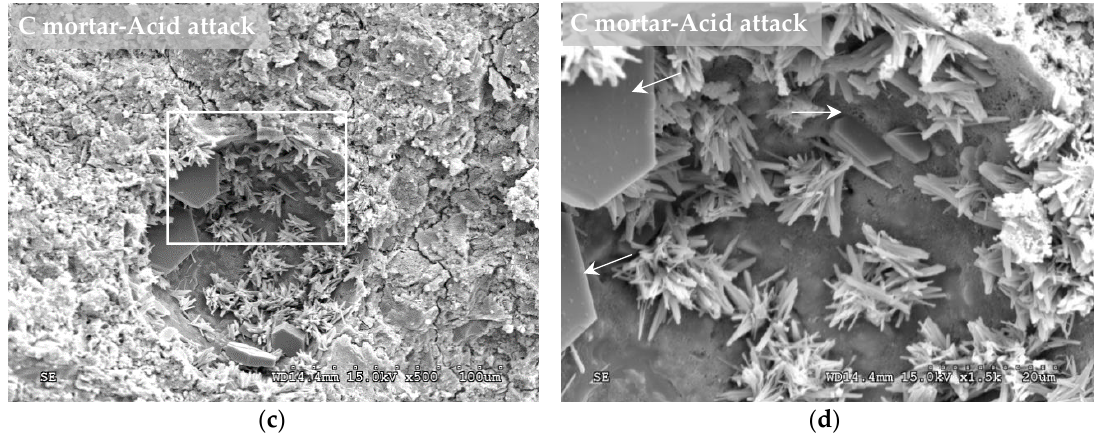
Figure 8. Scanning electron microscopy (SEM) images performed at 84 days (12 weeks) from the mortar manufacture. Left ( a , c ): images at 500 × magnification. Right ( b , d ): zoom at 1500 × magnification on the left image square. Top ( a , b ): mortar type C (with 1.5% of crystalline admixture) kept in a nonaggressive environment. Bottom ( c , d ): mortar type C exposed to a sulphuric acid attack for 56 days (8 weeks).